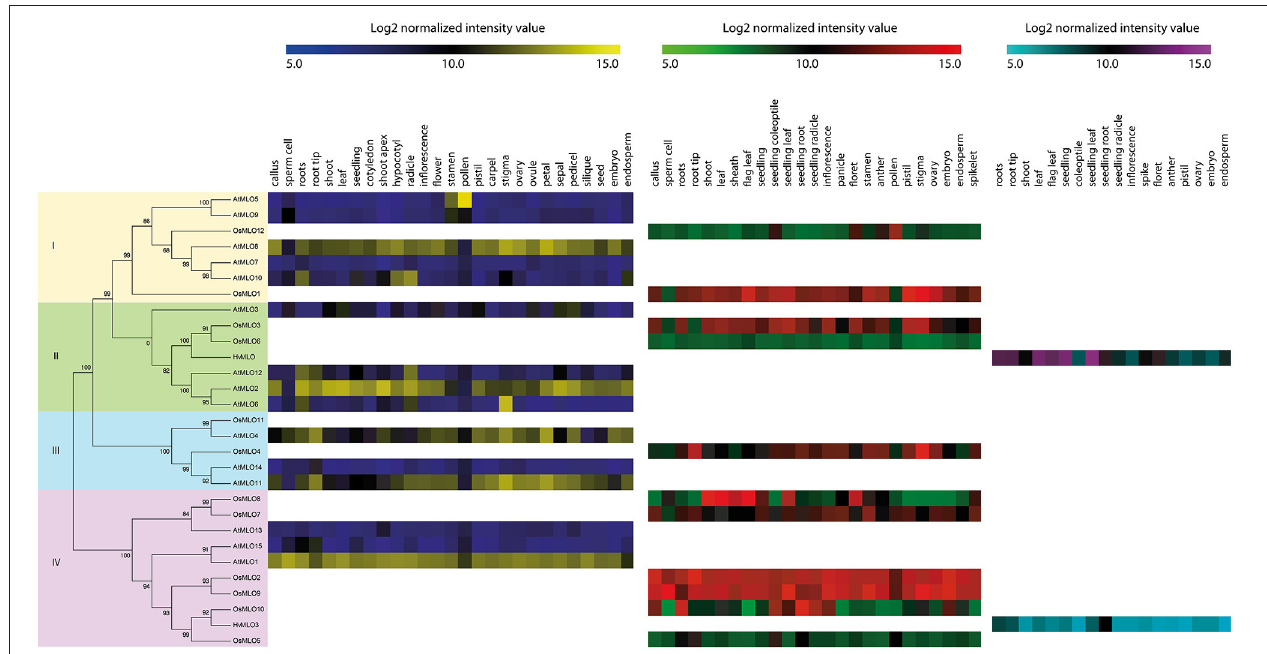
FIGURE 3 | Comparisons of expression patterns among OsMLO genes. Log 2 intensity values (colored by species) ranged from 5 to 15: Arabidopsis thaliana (blue to yellow), Oryza sativa (green to red), and Hordeum vulgare (cerulean to violet). OsMLO11 expression pattern was not available in Genevestigator data. Clade number is indicated on left side of phylogenetic